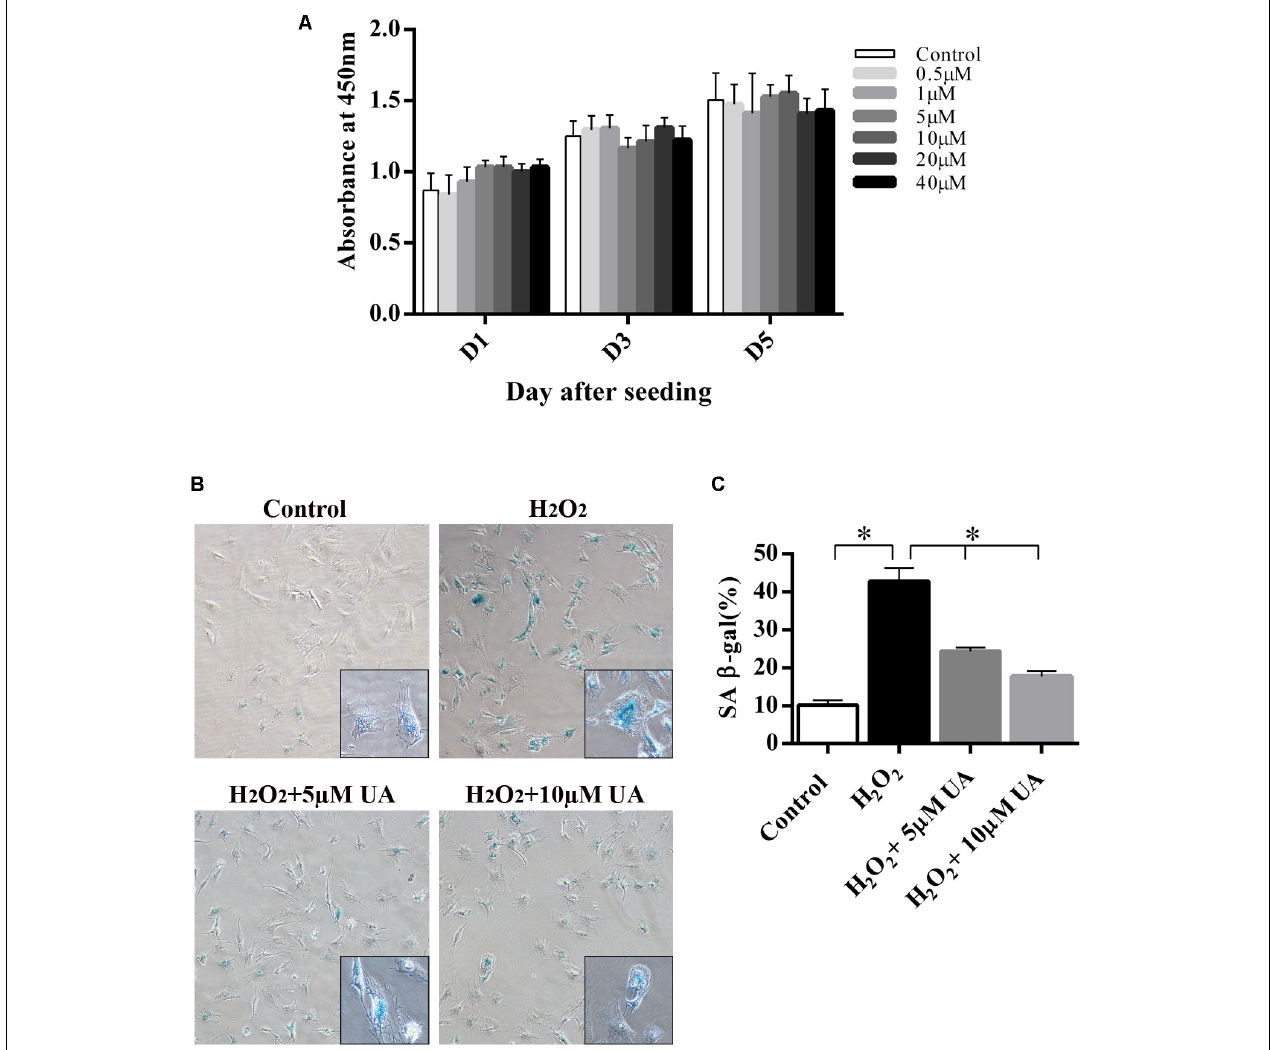
FIGURE 1 | The effect of UA on NP cell viability and UA treatment inhibits H 2 O 2 -induced cell senescence. (A) 1 × 10 3 NP cells were seeded in 96-well plates and treated with UA at the indicated concentrations for 5 days. Cell viability was determined by the CCK8 kit. (B,C) Results of the SA- β -gal staining assay (original magnification: × 100). NP cells were pretreated with different concentrations of UA for 12 h and then were treated with 50 µ M H 2 O 2 for 2 h. SA- β -gal staining was performed. The data represent the means ± SD. Significant differences between the treatment and control groups are indicated as ∗ P < 0.05 compared with the control